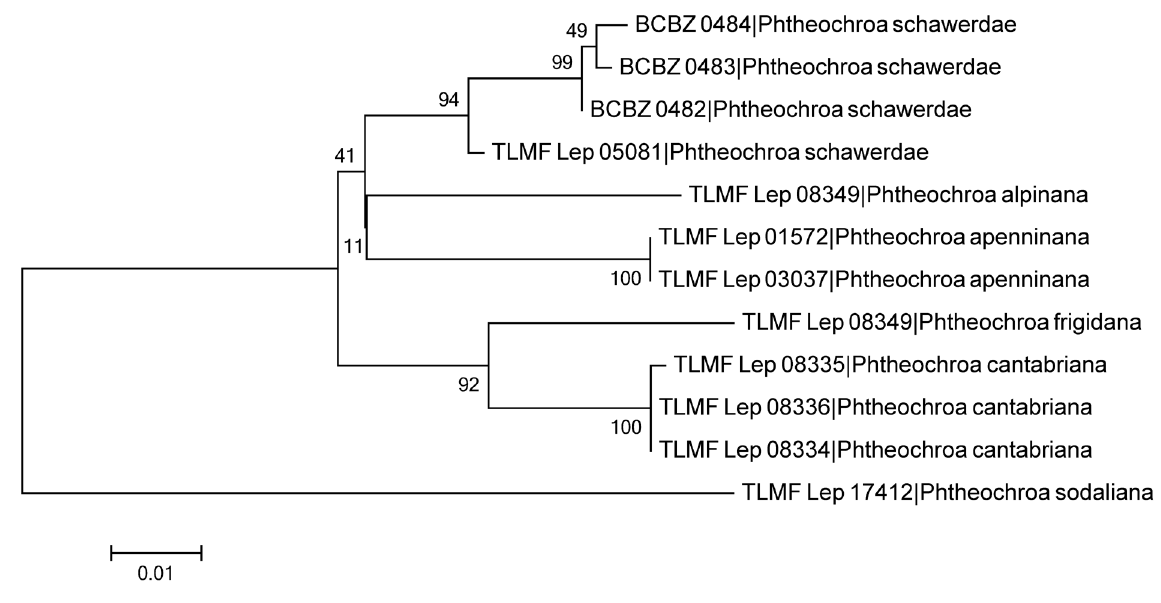
Fig. 9. Maximum likelihood tree (built with MEGA6) of cytochrome c oxidase subunit I (COI) barcode fragments. Values at the nodes are bootstrap support values based on 500